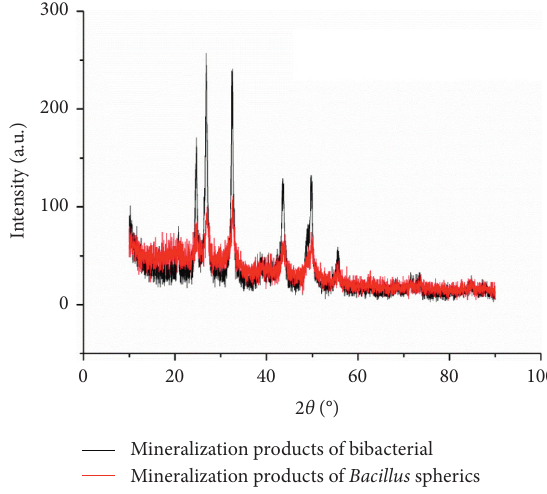
Figure 7: XRD patterns of the two samples.